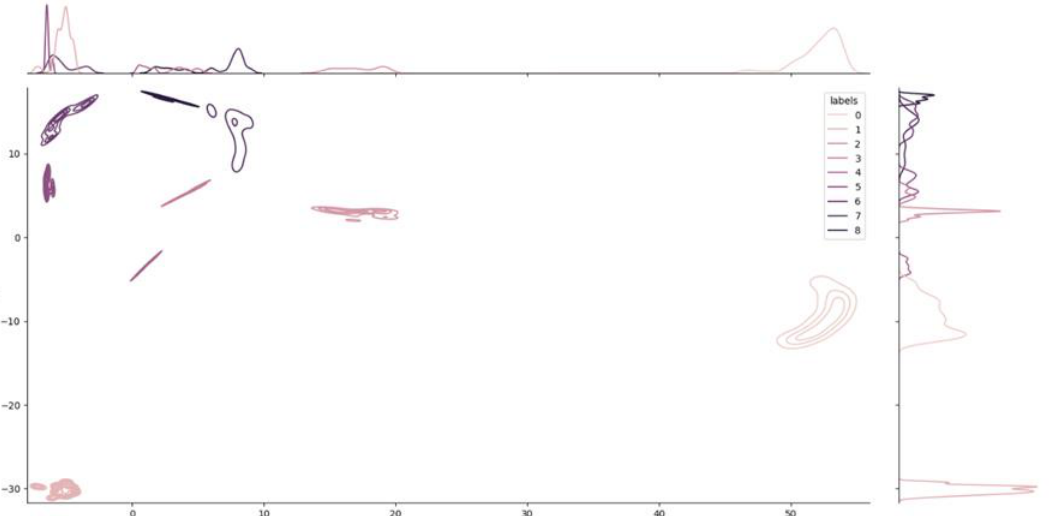
Figure 5. Joint Plot and density distribution of the clusters. Like an elevation map, the joint plot shows the local density of each cluster. The two plots on the two axes show the decomposition of the density into the two dimensions used for visualization. The dimensionality reduction from 64 to 2 dimensions was obtained using the UMAP algorithm.